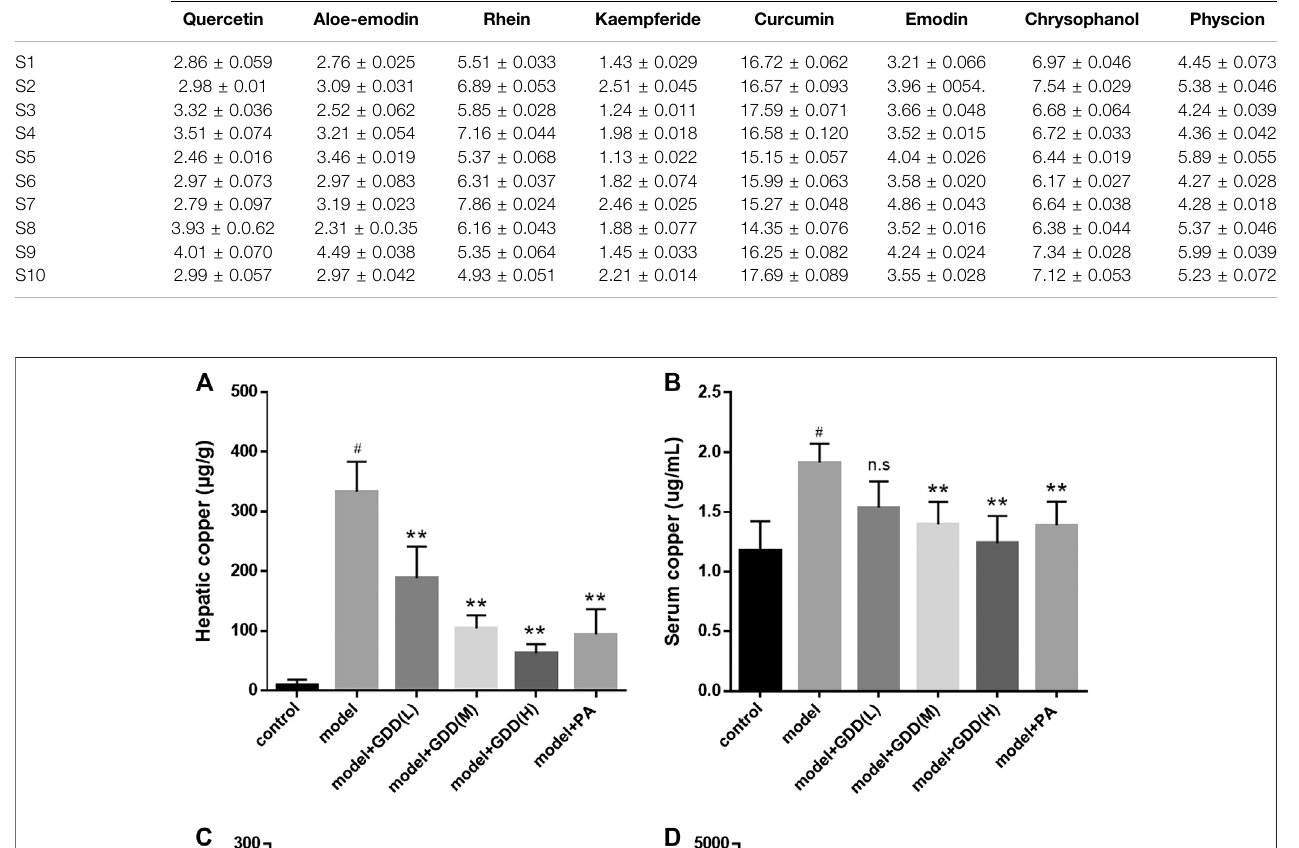
Frontiers in Pharmacology |